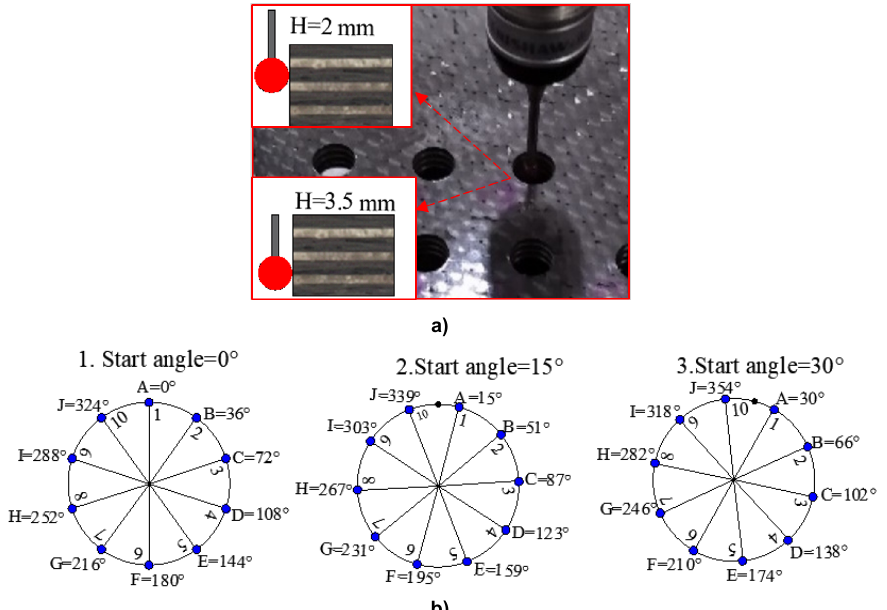
Figure 3. Measurements of Da and Re at two different depths with the probe: a) measurement points for the top and bottom surface of the hole, b) measurement positions depending on the starting angle (A = 0°, 15°, and